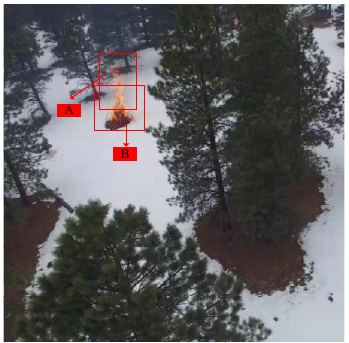
Figure 7. Schematic diagram of calculating the